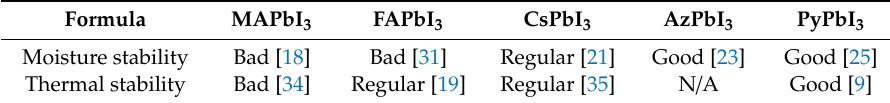
Figure 8. Schematic illustration of water-repelling mechanism in PyPbI 3 . The top five-membered ring stands for the Py molecule, and structure beneath represents PyPbI 3 perovskite.